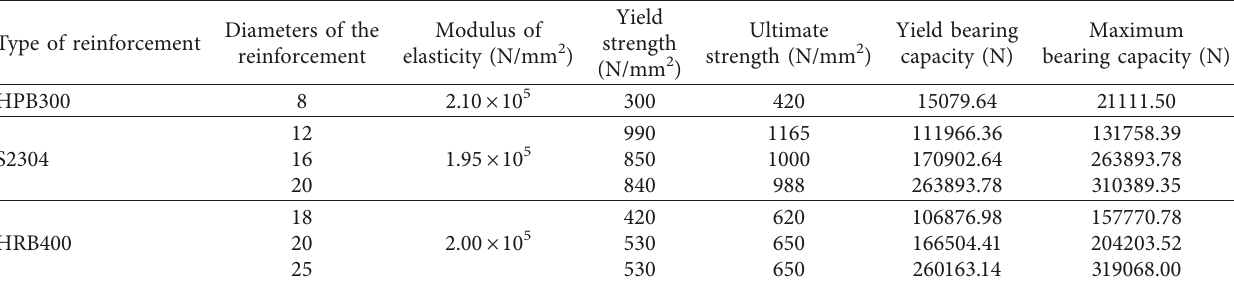
Figure 1: Layout of the reinforcements of the L20 specimen beam Table 1: Properties of the reinforcement material.